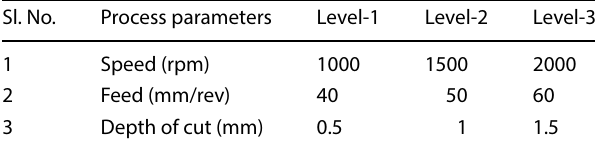
Table 1 Machining parameters and their level Sl.